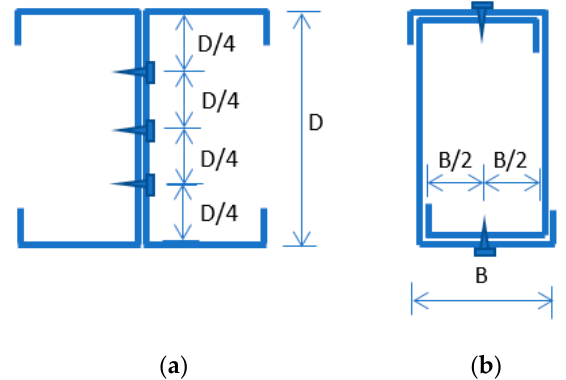
Figure 3. BTB ( a ) and BU ( b ) screw position at the column section.